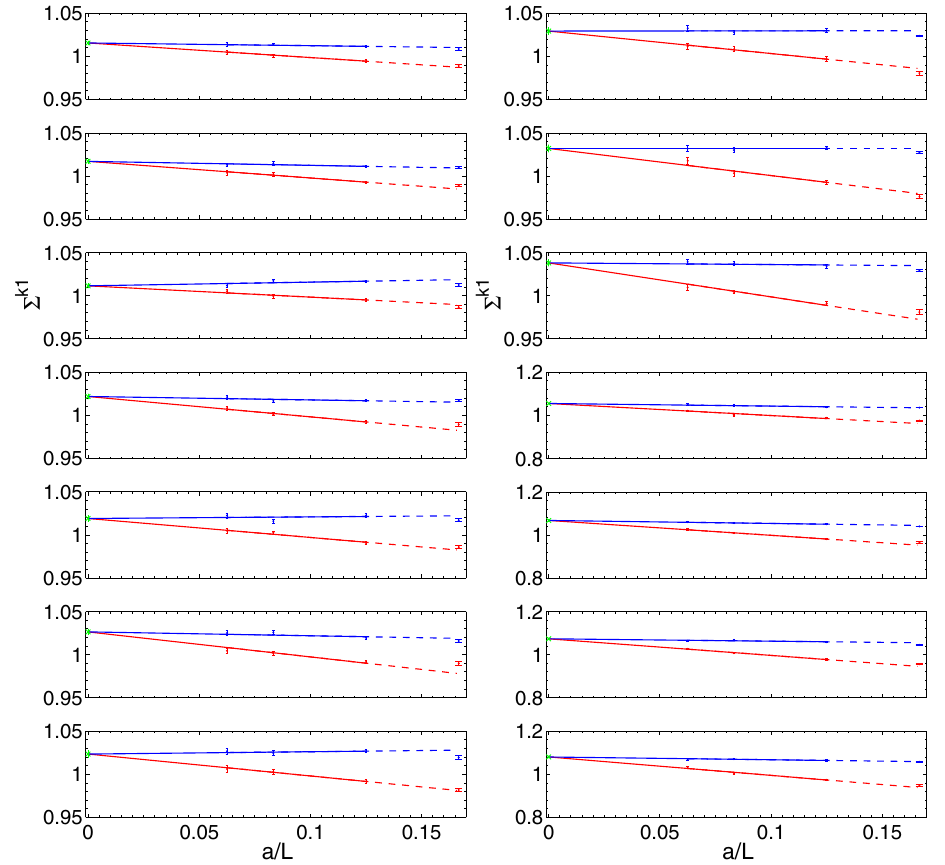
Fig. 4 Continuum limit extrapolations of the N f = 0 SSF for the renormalization scheme α = 1 / 2. Blue (red) points correspond to results with the O ( a ) improved (unimproved) action,